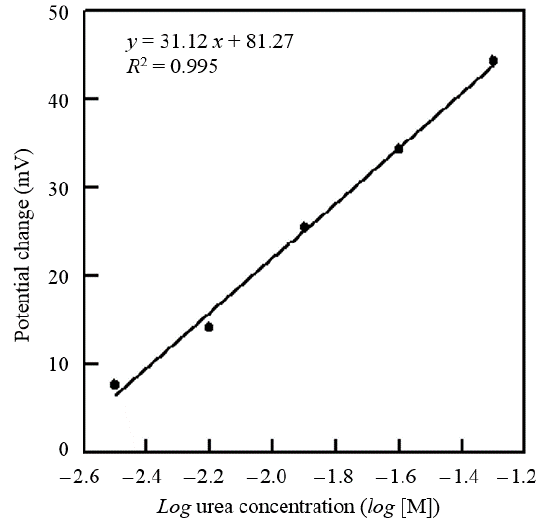
Figure 10. Characteristic curve of urea concentration in test samples.